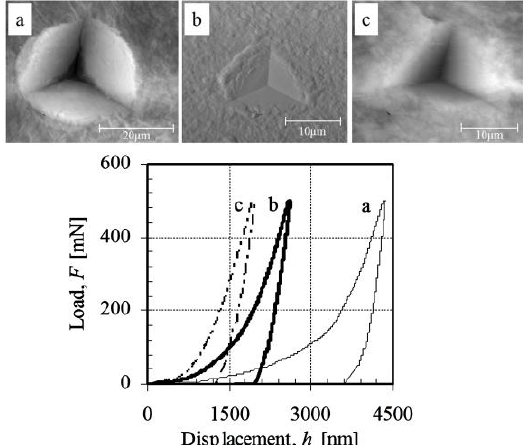
Figure 3. AFM images of typical indent impressions of ( a ) as-deposited; ( b ) annealed at 400 °C; and ( c ) annealed at 600 °C for 2 h (SnO 2 -MMT) 30 multilayers with MMT 0.4 wt % and corresponding load-displacement curves. (AFM: atomic force microscopy; MMT: montmorillonite)